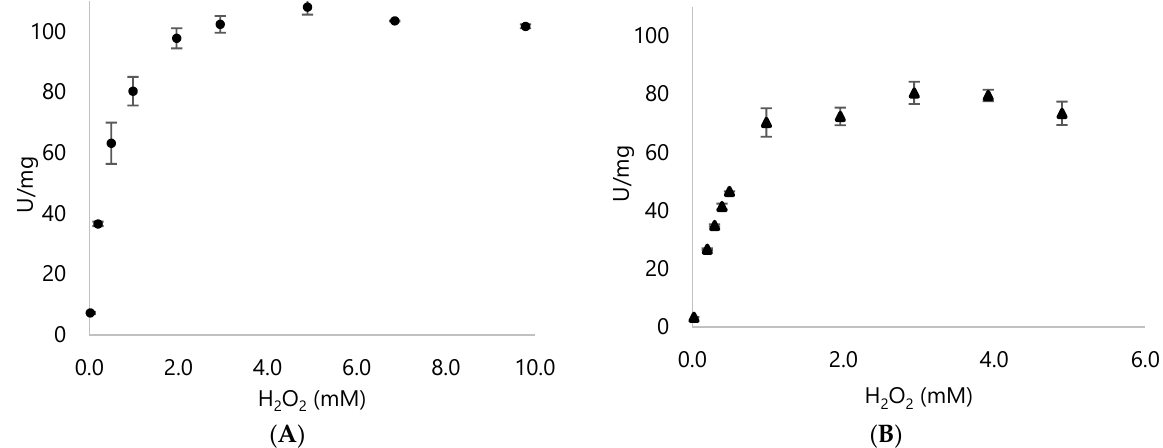
Figure 4. Specific activity of ( A ) DypA at pH 4.3 and ( B ) DypB at pH 5.0. Both enzymes were tested with different buffers using Britton-Robinson buffer as a standard for comparison with respect to activity. Potassium phosphate buffer was used only for DypB since most of the buffers tested showed a decrease in activity when tested to citrate, citrate phosphate, and sodium acetate buffers.